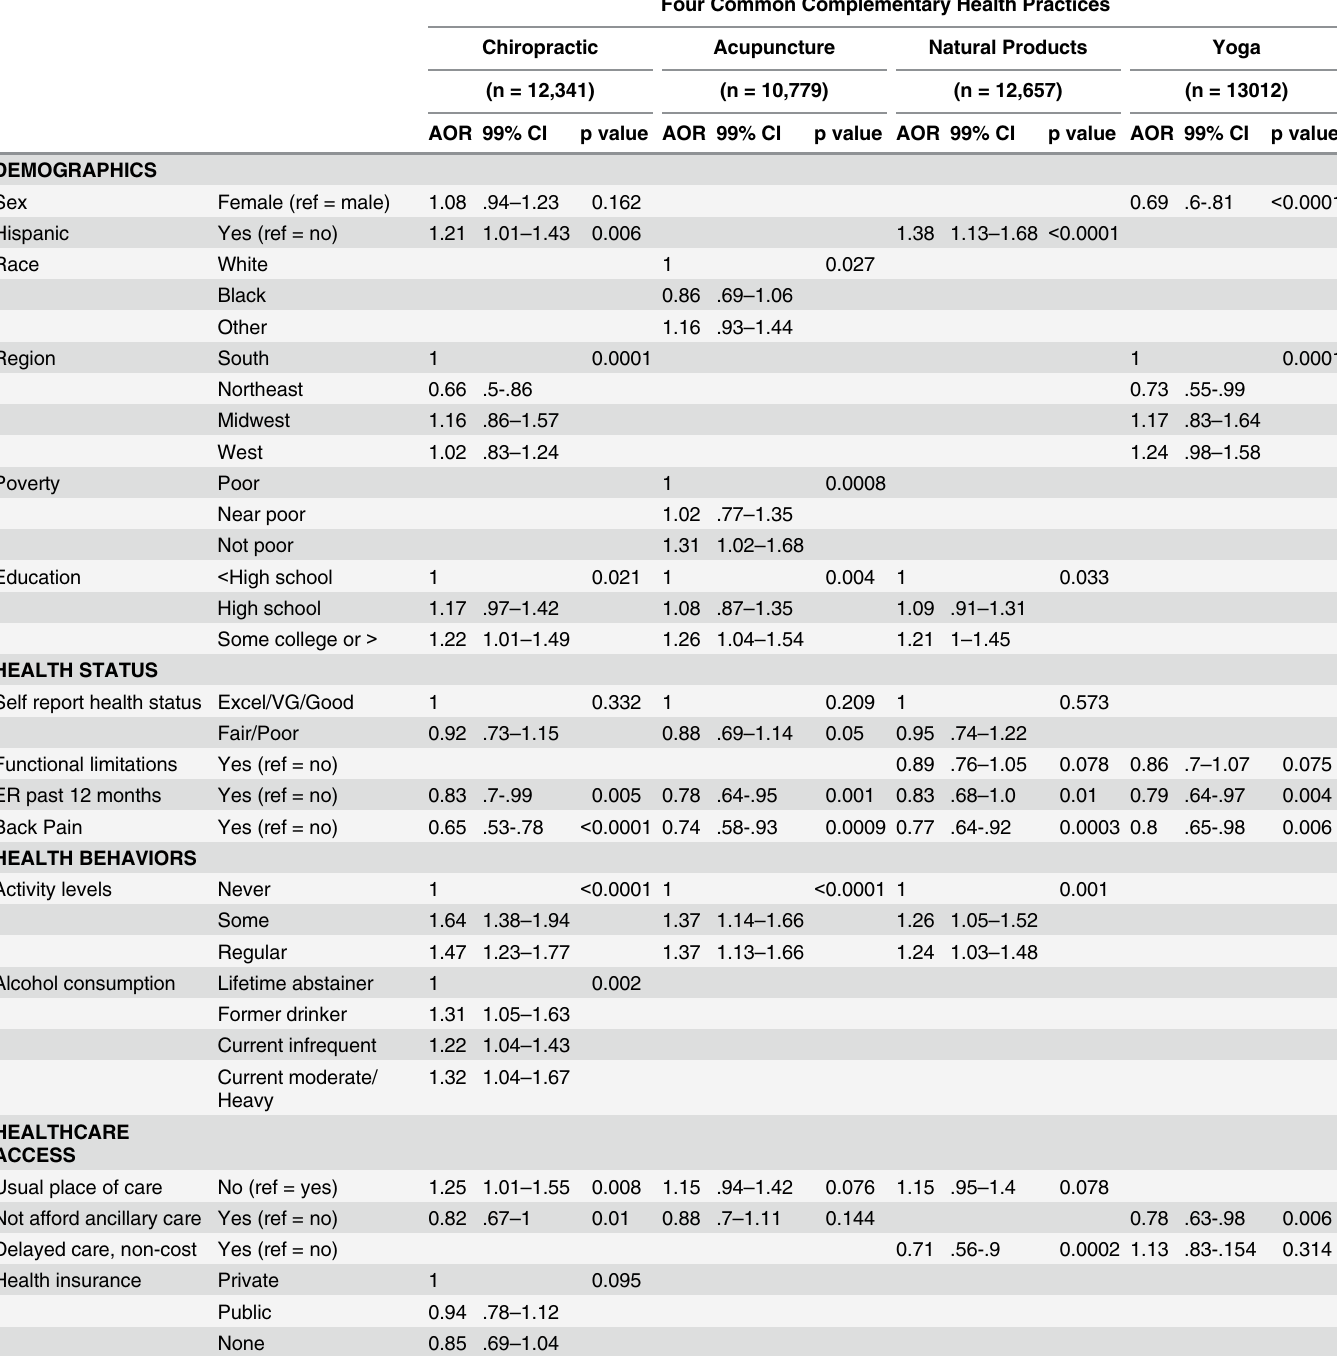
Table 3. Adjusted odds ratios and 99% confidence interval estimates of items independently associated with choosing 'lack of need' as a reason for non-use of four complementary health practices, full